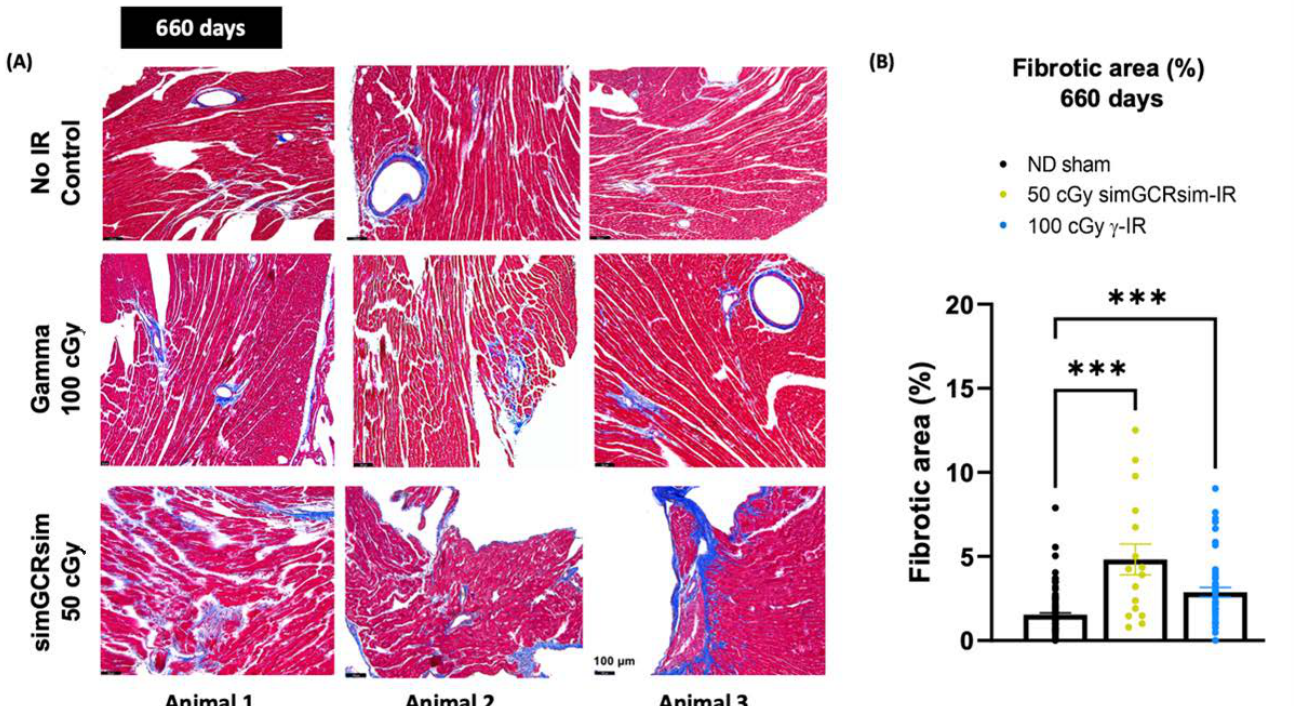
Figure 4. Myocardial fibrosis at 660 days post IR. Transverse sections of hearts at basal and mid- ventricular levels (four heart tissue sections taken 80 µ m apart from each other) were stained with Masson’s Trichrome to assess fibrotic burden. ( A ) Representative images of heart sections from three different animals show fibrosis, highlighted in bright blue, in contrast with dark, red-stained myocardium. Scale 100 µ m, 200 × magnification. ( B ) Fibrosis burden in heart tissue was quantified using the ImageJ program, with the fraction of the blue stained area being normalized to the total red area. n = 3 mice per treatment condition; p -values were calculated using one-way ANOVA. *** p <